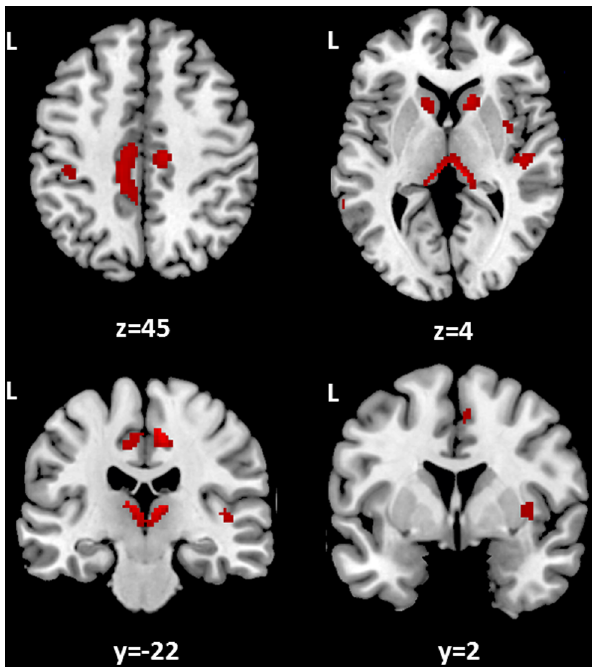
Figure 3. Association between lesion load and GM atrophy in MS brain. There are shown here in red, those brain areas in which local GM volumes are negatively associated with T2-weigthed lesion loads in the whole MS population. This association indicates that MS patients with larger lesion load tend to develop more GM atrophy in the thalamus, the head of the caudate nucleus and the cingulate cortex bilaterally, in the right insular cortex, and in the left postcentral gyrus. Statistical threshold: p values FWE-corrected , 0.05. Spatial coordinates (x,y,z) in the figure are in MNI space.